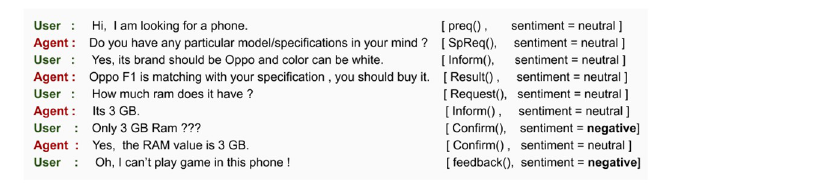
Fig 13. A sample that shows new goal formulation